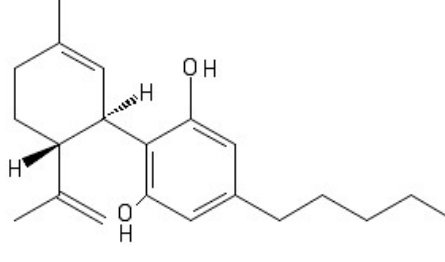
Figure 1. Structure of CBD.